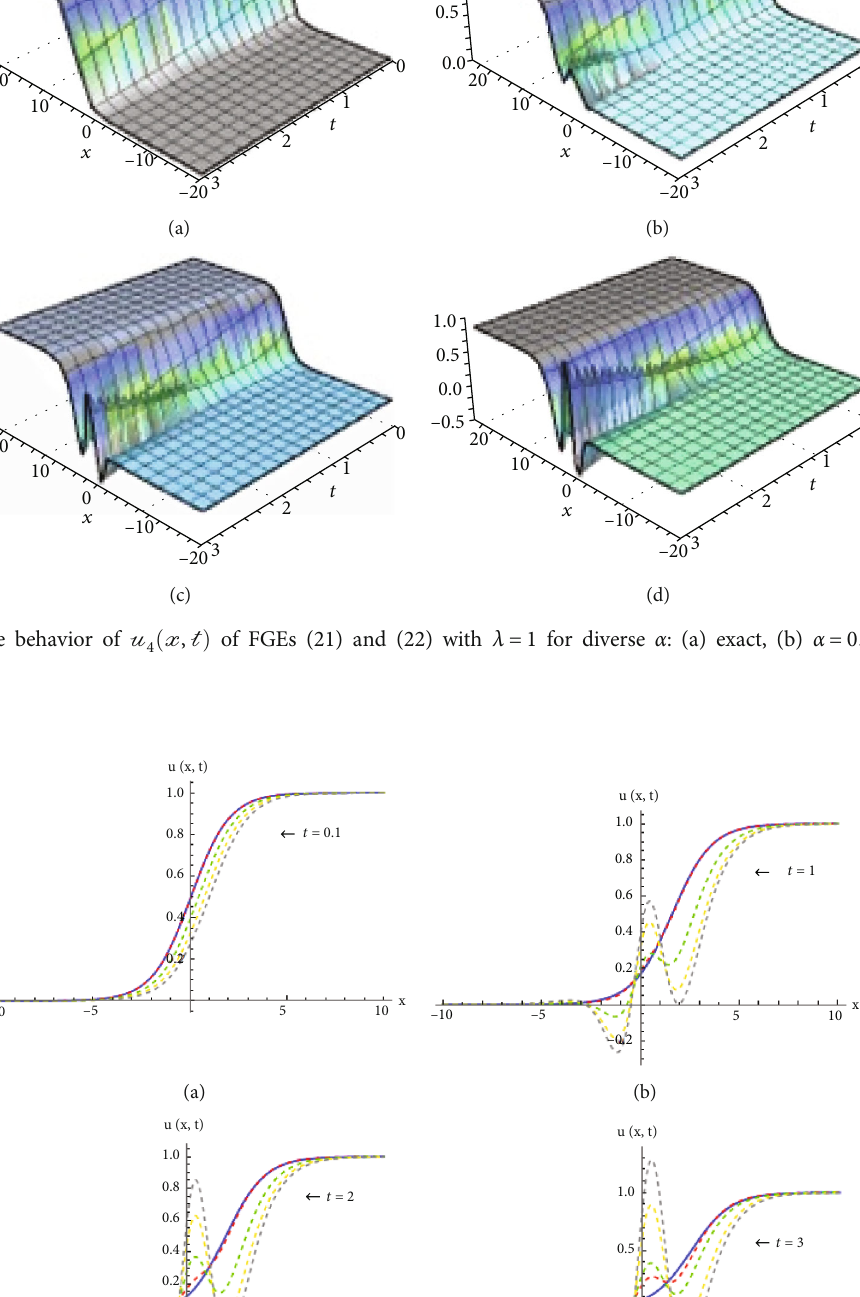
x , t Þ of FGEs (21) and (22) with λ = 1 and fi xed t for various values of α , in which exact blue, Figure 2: Elevation of wave surface of u 4 ð α = 1 red, α = 0 : 75 green, α = 0 : 5 yellow, and α = 0 : 25